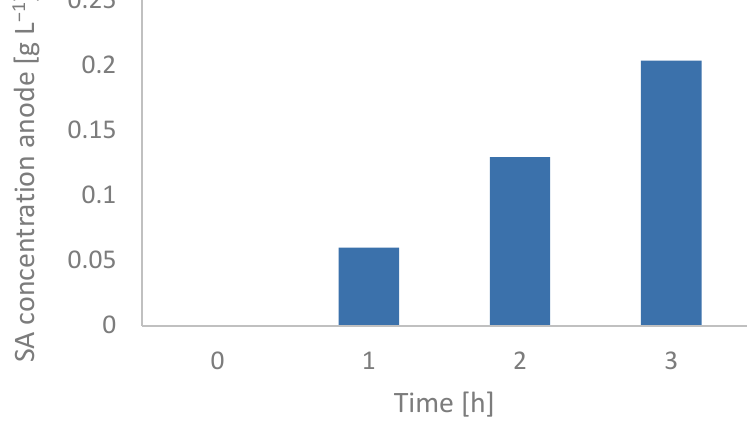
Figure 6. Measured concentration of succinic acid (SA) in the anode chamber during the concentration gradient experiment in the absence of applied voltage. Initial concentration in the cathode chamber was 50 g L − 1 and initial concentration of NaCl was 24.75 g L − 1 , which corresponds to twice molar concentration with respect to succinic acid because succinate is double charged. The succinic acid was extracted in the anode chamber due to the Gibbs–Donnan effect.